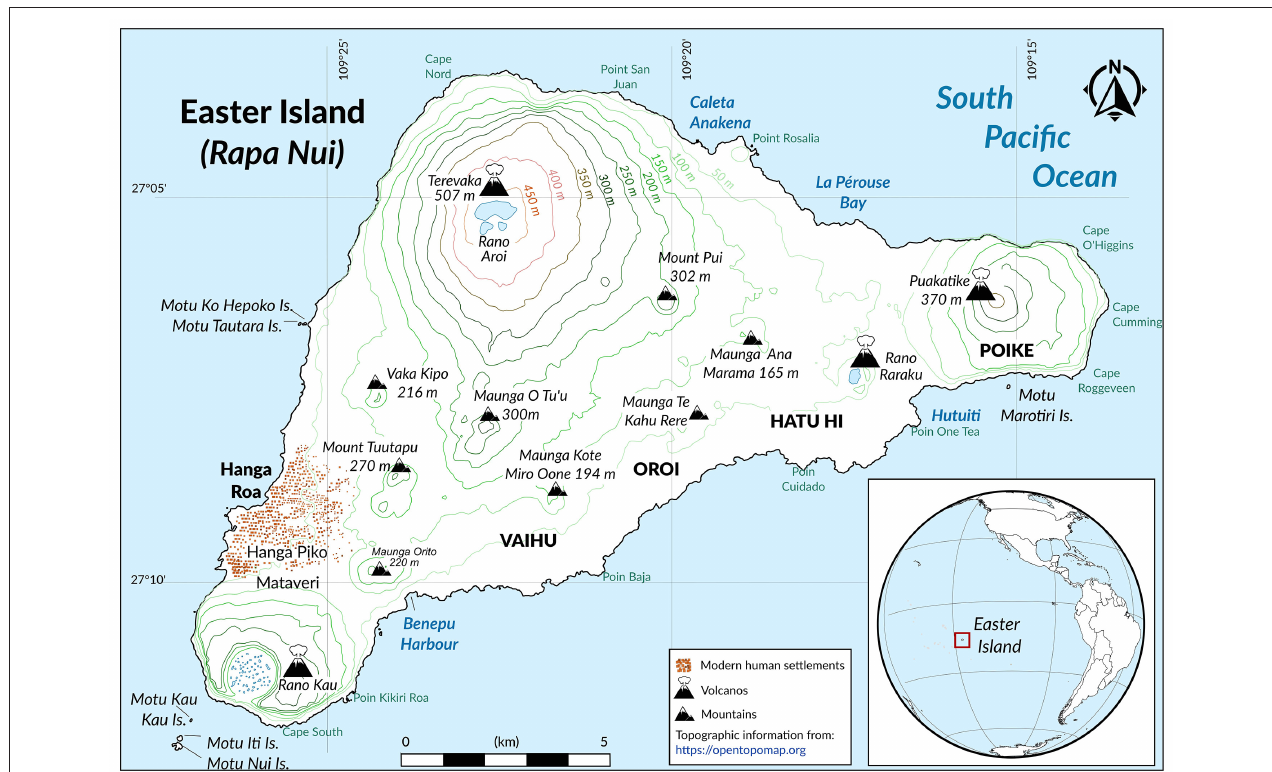
FIGURE 1 | Geography of Easter Island and its location (inset) in the South Pacific. The small size, about 165km 2 , and isolation make the island a natural laboratory for studying past human-resource interactions. Map courtesy of Jailson Fulgencio de